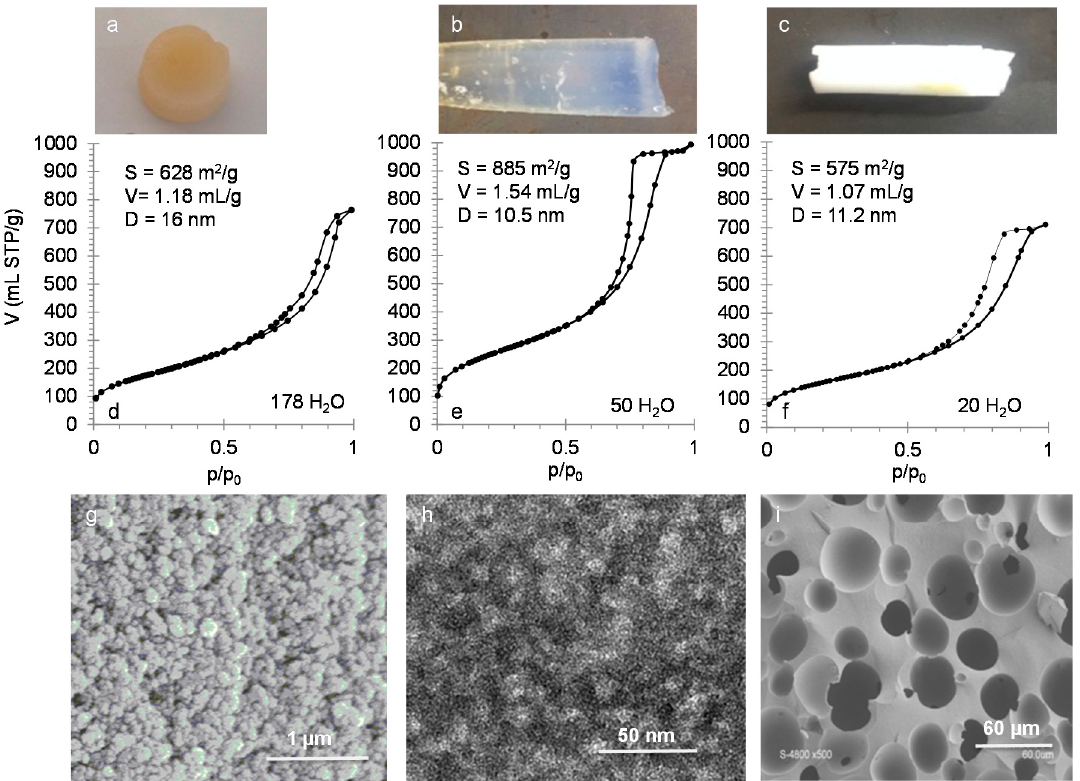
Figure 12. ( a – c ) Characteristic images of the monoliths prepared with high amounts of water (50 and